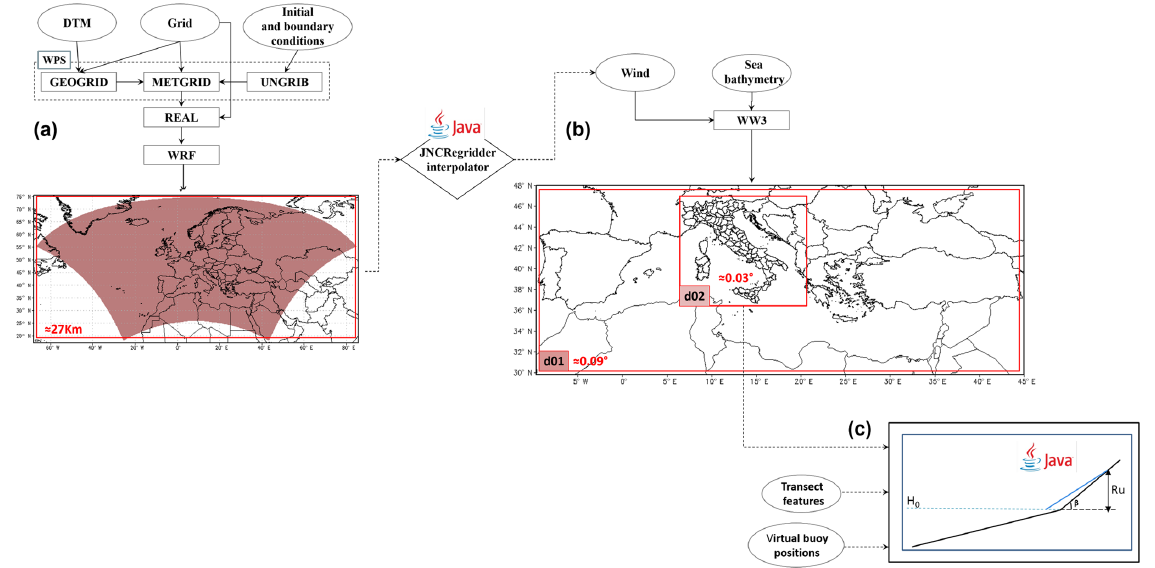
Figure 4. Model chain from the atmospheric model WRF (a) to the offshore wave model WW3 (b) and the run-up calculator (c) . The block diagram shows evidence of the input–output components of the model coupling data flux.